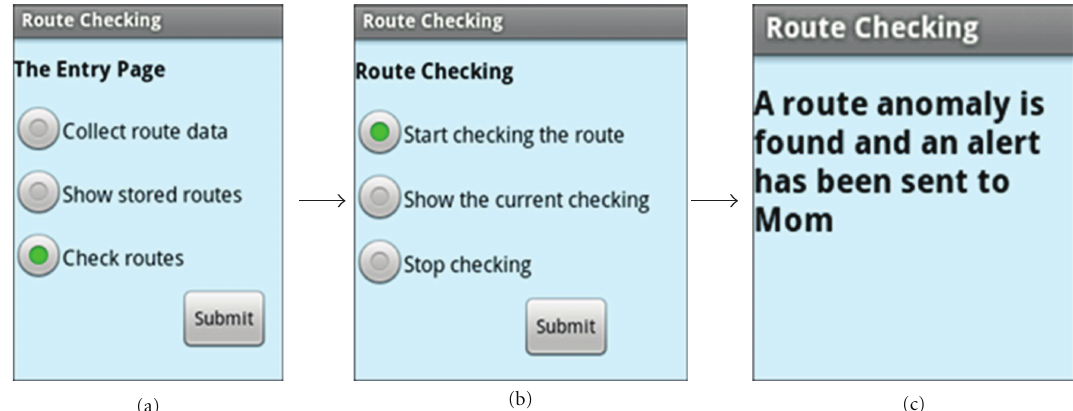
Figure 9: (a) The entry page of the application, (b) the page of route checking, and (c) an acknowledgment message after detecting a route anomaly.